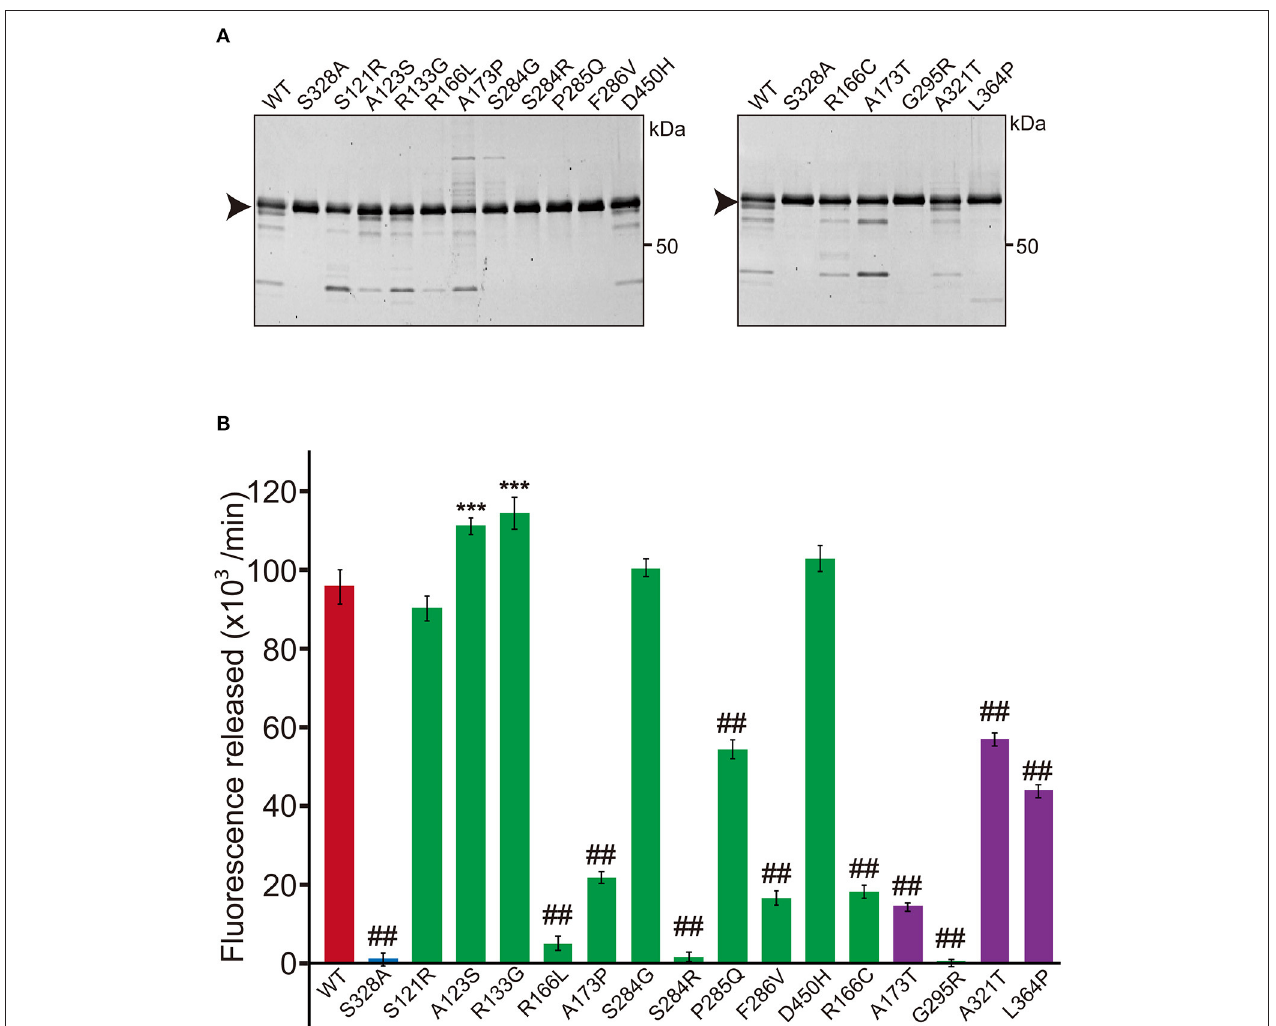
FIGURE 1 | Protease activity of missense HTRA1s identified in symptomatic carriers. (A) SDS-PAGE of WT and missense mutant HTRA1 proteins used in the protease assay. Black arrows indicate the full-length band of HTRA1 tagged with myc-His 6 . (B) Protease activities of missense HTRA1s identified in symptomatic carriers and CARASIL patients. Activities were calculated from the slope of the linear portion of the normalized fluorescence vs. time (30, 60, 90min) plots. Mean values from 3 independent experiments are shown. Red and blue bars indicate protease activities of WT and S328A, the positive and negative controls, respectively. Green bars indicate protease activities of missense HTRA1s identified in symptomatic carriers. Purple bars indicate protease activities of missense HTRA1s identified only in CARASIL patients. I-bars indicate standard errors (SE). Statistical comparisons of protease activities between WT and each missense HTRA1 protein were performed with one-way analysis of variance followed by the Dunnett’s post hoc test. *** P < 0.0001 for protease activities of each HTRA1 relative to WT. ## P < 0.0001 for protease activities of HTRA1 relative to WT.